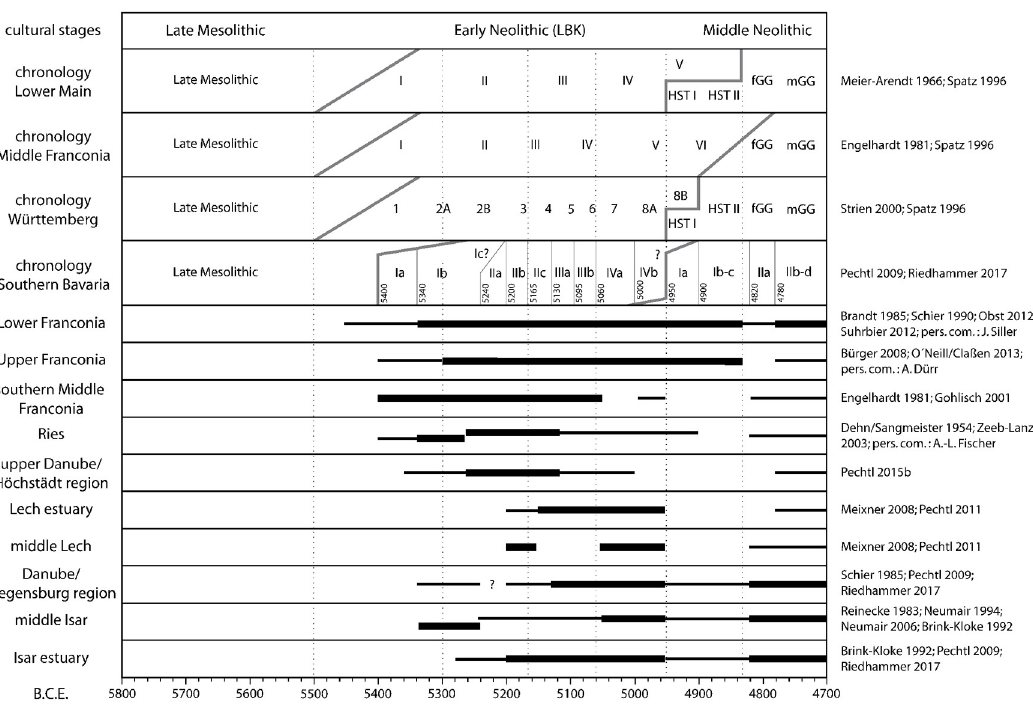
Fig 3. Comparison of the settlement dynamics during the LBK and the early Middle Neolithic in different settlement regions in Bavaria, Germany. Narrow lines indicate moderate settlement, thick lines indicate intensive settlement and lateral off-set equals spatial discontinuity of